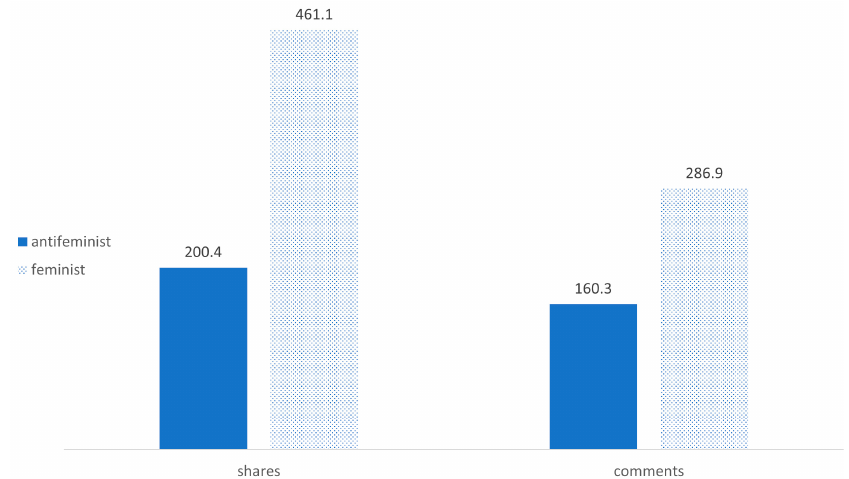
Figure 1. Number of shares and comments on feminist and antifeminist content expressed in thou-